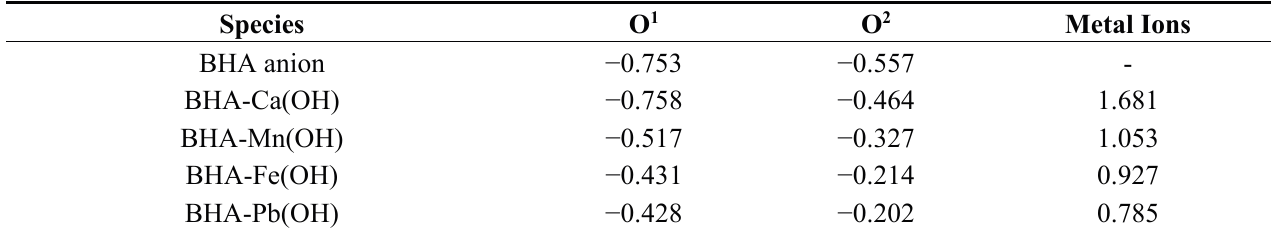
Table 4. Mulliken charges of O atoms and metal ions. Species